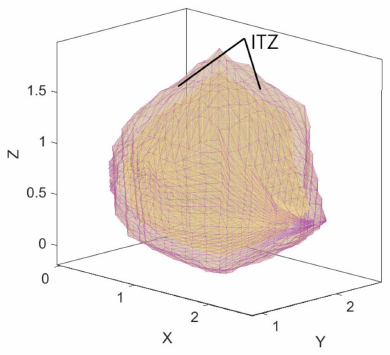
Figure 3. Generation of interfacial transition zone